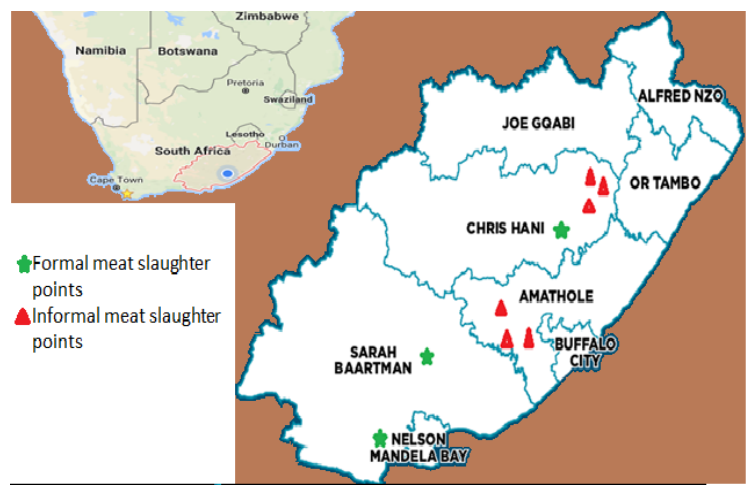
Figure 1. Map of the Eastern Cape Province showing sampling points.